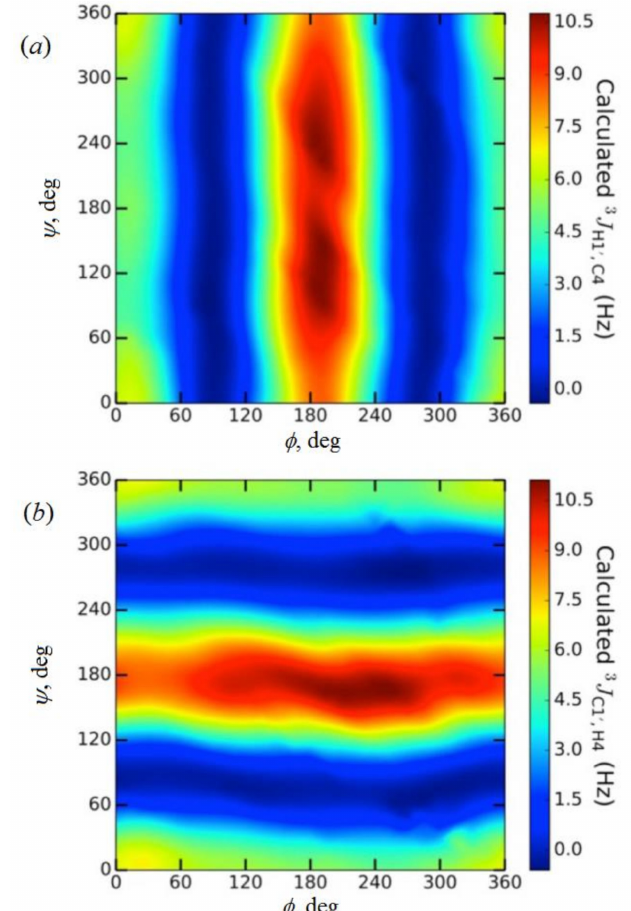
Figure 42. ( a )—2D contour plot of calculated 3 J (C-4,H-1 (cid:48) ) values in β -D-galactopyranosyl-(1 → 4)- β -D-glucopyranoside ( 78 ), showing a primary dependency on ϕ ; ( b )—Contour plot of calculated 3 J (C-1 (cid:48) ,H-4) values, showing a primary dependency on ψ . Reproduced from Zhang et al. [150] with the permission of the American Chemical